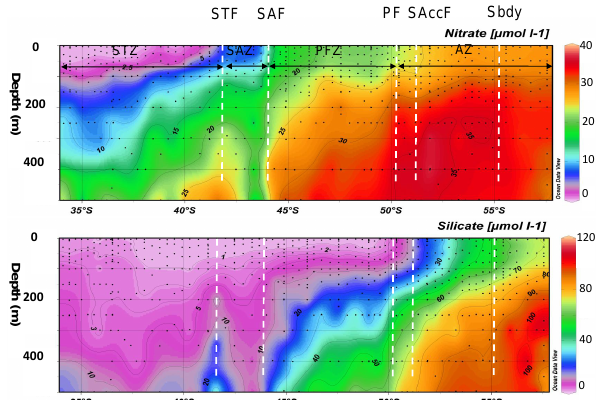
Figure 3 a, b. Profiles of NO 3 and Si(OH) 4 in the upper 500 m along the Bonus Goodhope Cruise track (taken from LeMoigne et al., 2011). It shows increasing surface nutrient concentrations with increasing latitude. Frontal positions are indicated by the white vertical dotted lines.